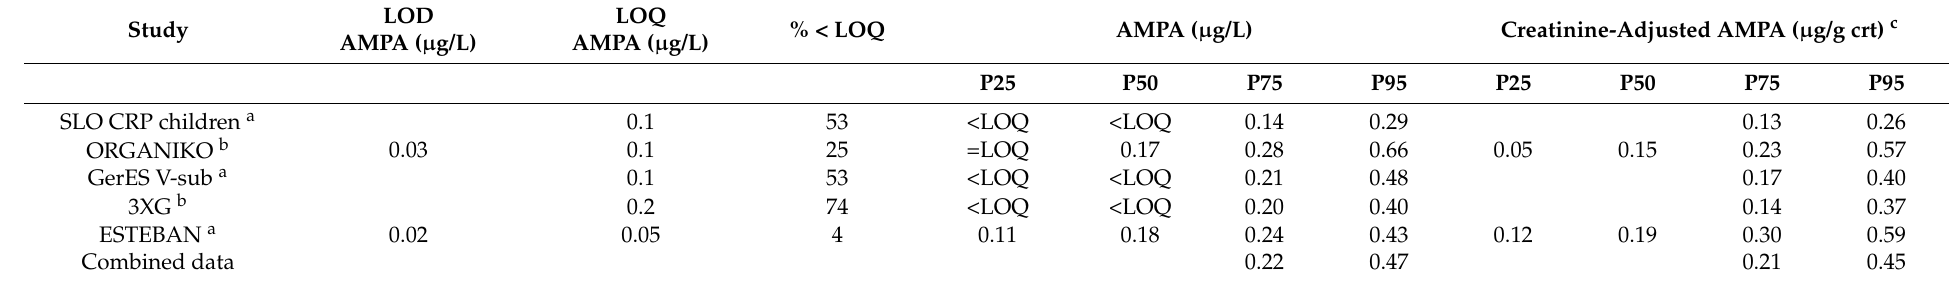
Table 2. Summary of urinary AMPA concentrations in European children (6–11 yrs.) from the HBM4EU-aligned studies.